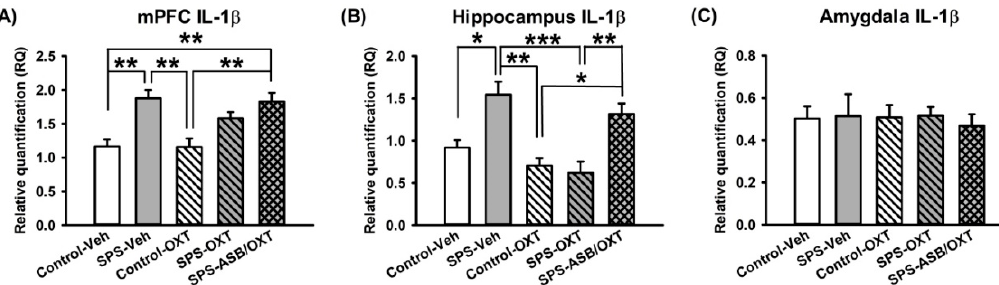
Figure 3. SPS and drugs (OXT and ASB) changed the mRNA expression of central IL-1 β . Medial prefrontal cortex (mPFC) IL-1 β levels were increased following SPS, which could not be reversed by OXT ( A ). OXT reversed SPS-elevated IL-1 β levels in hippocampus, and ASB further blocked the OXT effect ( B ). SPS and drugs had no effect on amygdala IL-1 β levels ( C ) . n = 5 for each group; SPS = single prolonged stress, Veh = vehicle, OXT = oxytocin, ASB = atosiban, OXTR = oxytocin receptor. Bars represent mean ± SEM; * p < 0.05, ** p < 0.01, *** p < 0.001.